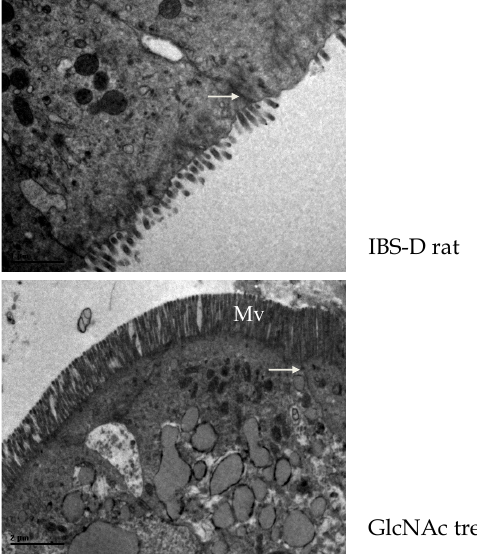
GlcNAc treated Figure 1: Electron microscopy of cell membrane and microvilli (Mv) in the intestinal mucosa of IBS-D rats with or without GlcNAc treatment. Arrow: tight junction